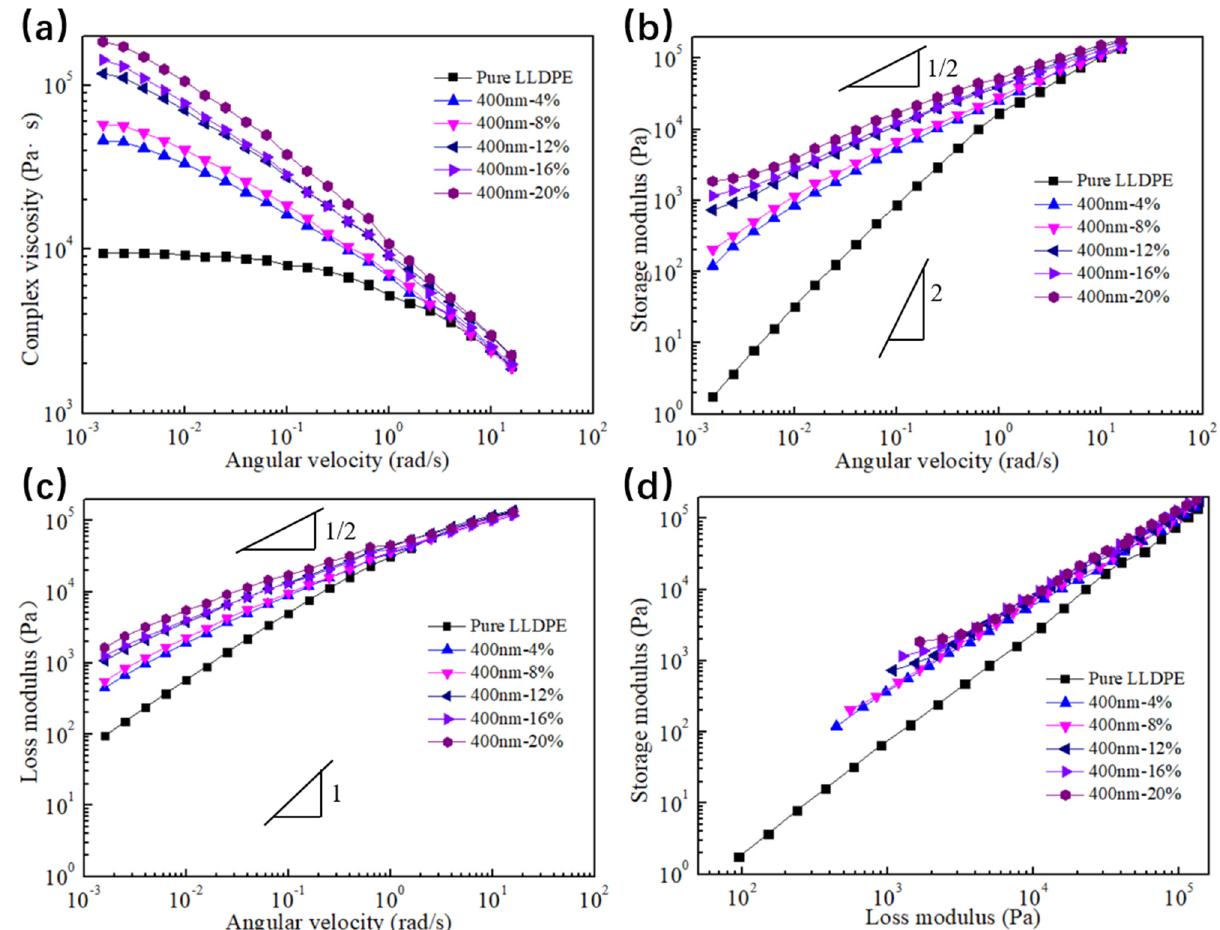
Figure 3: Dynamic rheological properties of the nano Al 2 O 3 /LLDPE composites with di ff erent Al 2 O 3 contents: ( a ) complex viscosity, ( b ) storage modulus G ′ , ( c ) loss modulus G ″ , and ( d ) Han